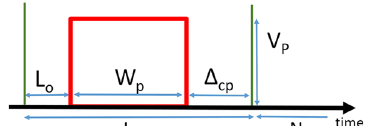
Fig. 5 Illustration of rectangular power signal parameters. Refer to Sect. 3.3 for the explicit definition of these parameters